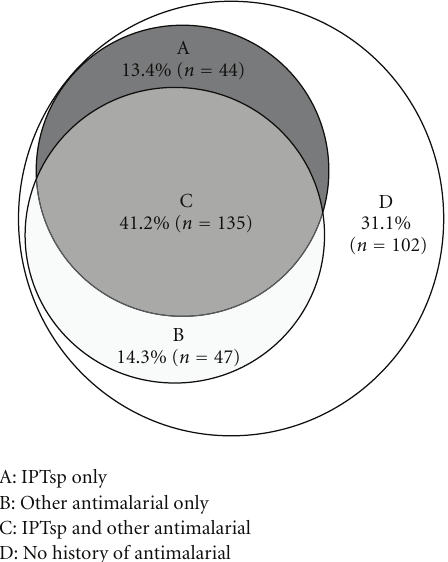
(15/164; 27 HIV results could not be cross-checked on the antenatal clinic cards). Figure 2: Distribution of antimalarial (IPTsp or any other antimal- arial ) use during pregnancy, September 2009, Central African Republic. IPTsp: intermittent preventive treatment with sulfadoxi-